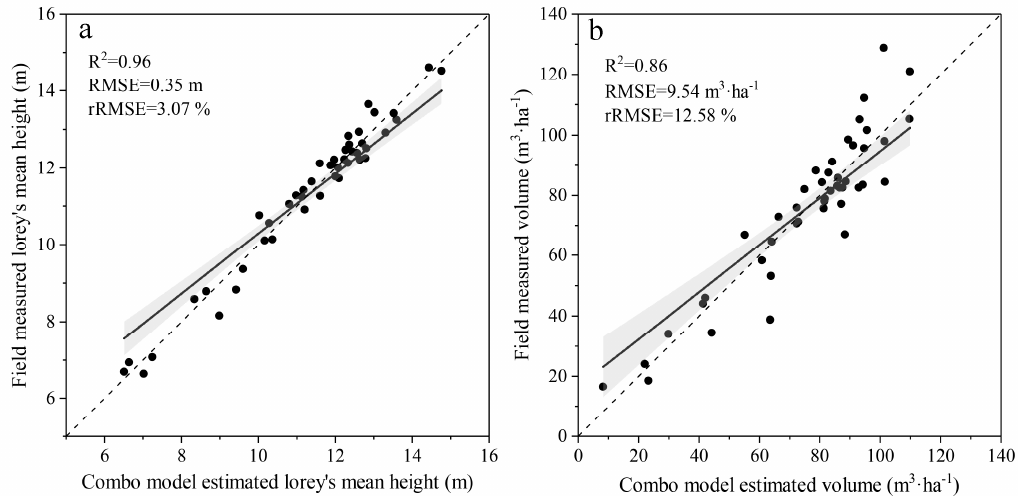
Figure A2. Scatterplots of forest structural attributes between the field measured and combo model predicted.